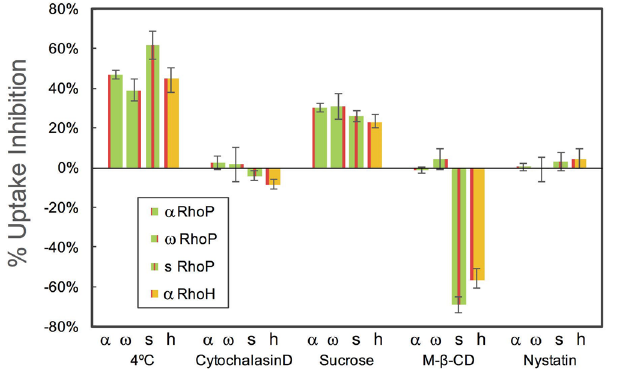
Figure 5. Effect of endocytosis inhibitors on the uptake of RhoPs by HeLa cells. The fluorescence intensity of HeLa cells was evaluated by flow cytometry. The 100% of Mean F.I. are the values of each RhoP in the absence of inhibitor incubated at 37 °C for 1 h. α : α RhoP-18k, ω : ω RhoP-21k, s: sRhoP-18k and h: α RhoH-30k. Cytochalasin D: 10 µ M, Sucrose: 0.45 M, M β CD: 10 mM, Nystatin 27 µ